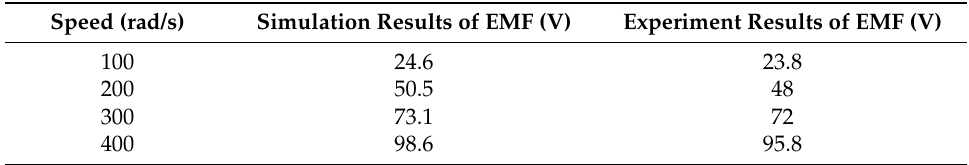
Table 9. No-load back electromotive force under different rotating speeds.